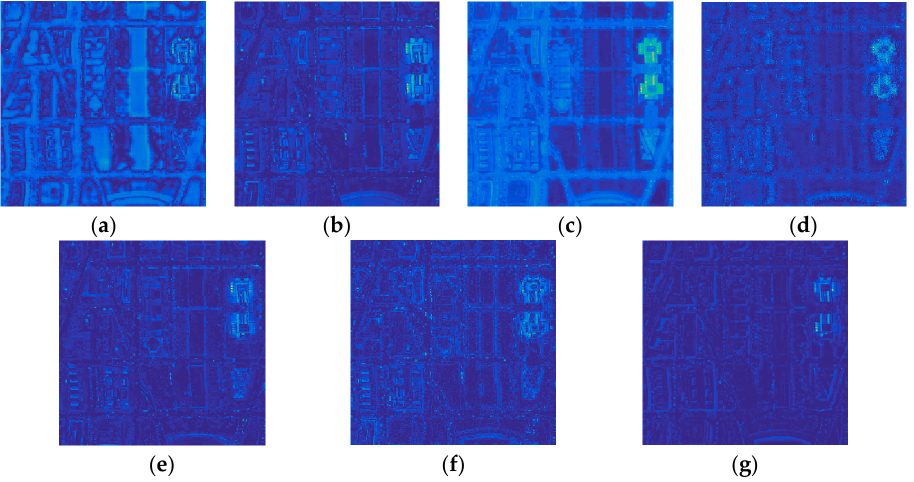
Figure 10. Error images of the competing methods for Washington DC dataset. ( a ) PCA; ( b ) GFPCA;